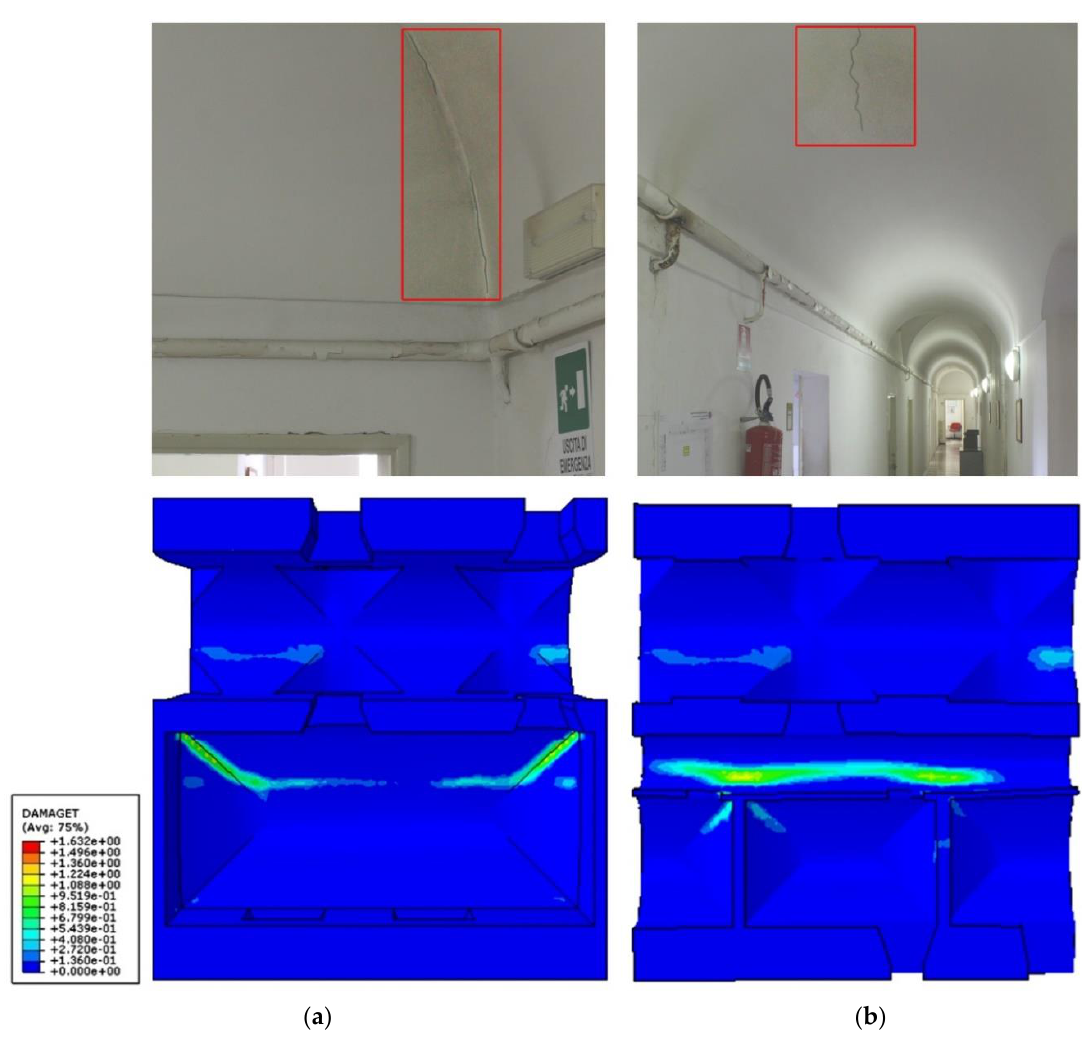
Figure 15. Comparison between the damage survey and the crack pattern at the vaults’ intrados coming from the finite element analysisfor inwards seismic action: ( a ) ground floor; ( b ) mezzanine floor. The damages are between 0 and 1.6.